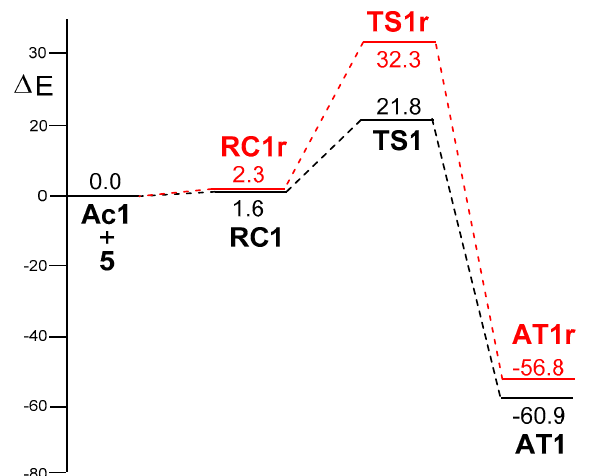
Figure 8. Energy profiles (in kcal / mol) of the two regioisomeric reaction paths associated with the mononuclear AgAAC reaction of Ac1 with 5 .